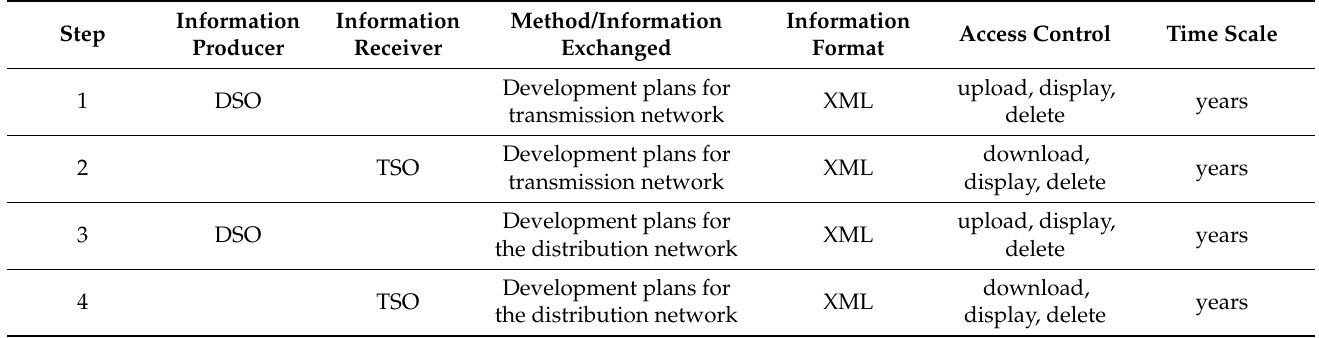
Table 2. Step-by-step procedure of use case scenario.